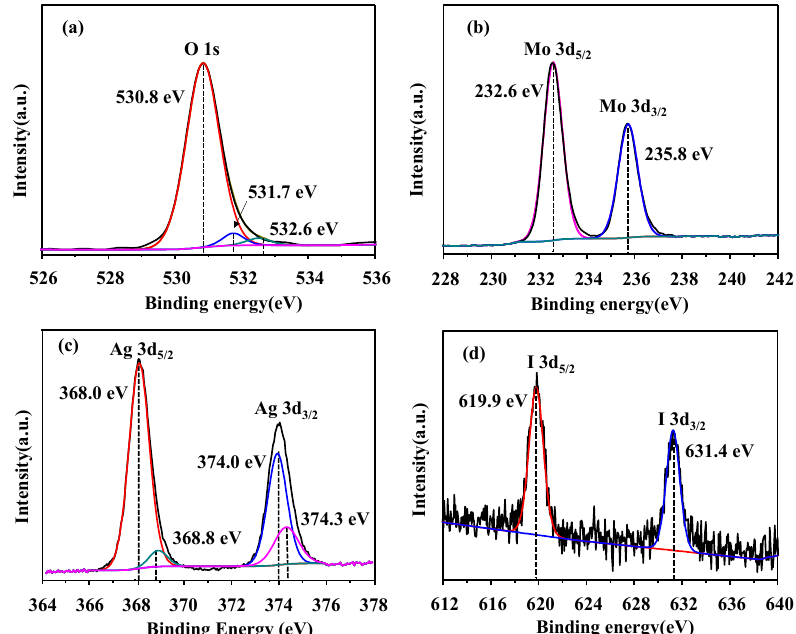
reveal the formation of a ternary heterojunction, Ag / AgI / α -MoO 3 , which probably further promotes Nanomaterials 2019 , 9 , x FOR PEER REVIEW the e ff ective separation of electrons and holes between the Ag, AgI and α -MoO 3 .